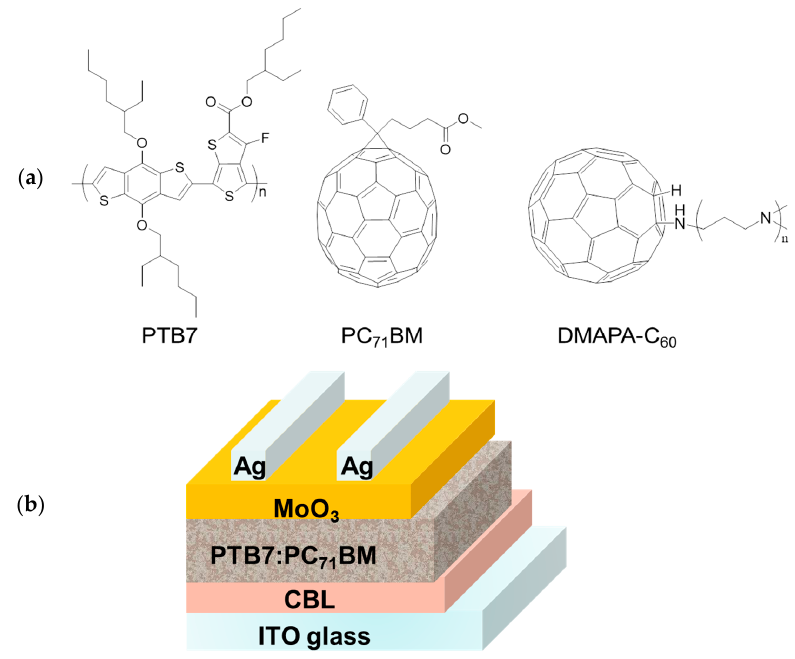
Figure 1. ( a ) Chemical structures of PTB7, PC 71 BM, and DMAPA-C 60 ; ( b ) Device structure of the inverted